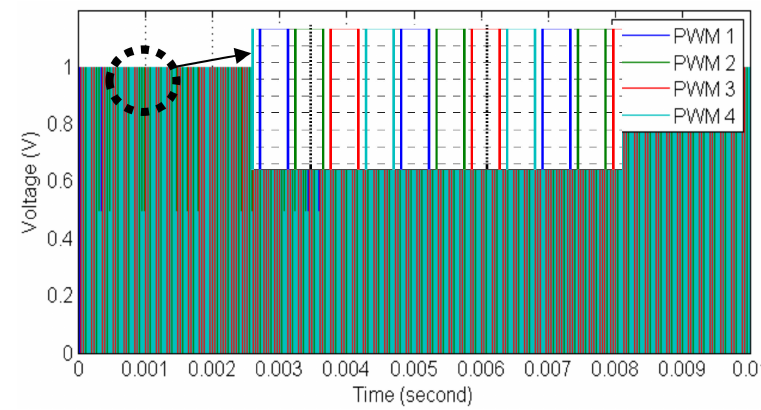
Figure 4. PWM control signals for duty cycle equal to 0.2.